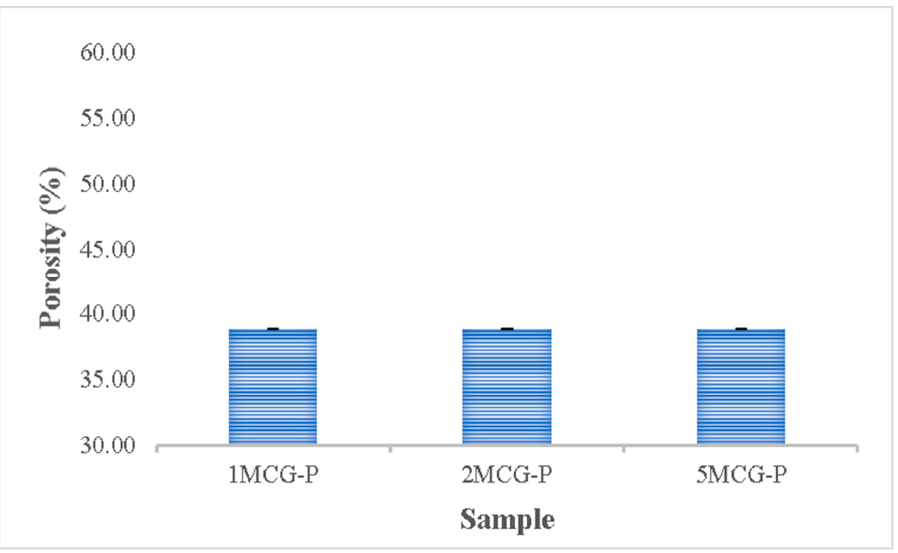
Figure 10. Porosity of CS/Gel/MMT/PCL bone scaffolds (without significant difference).